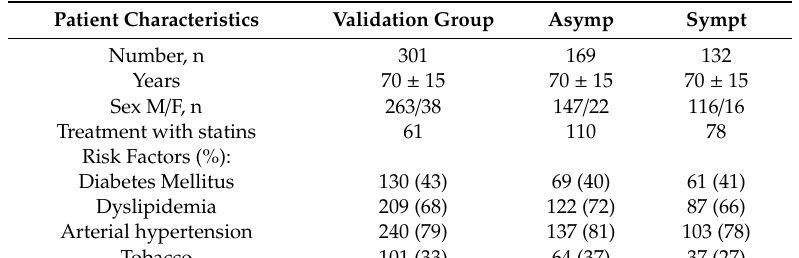
Table A2. Clinical and demographic patient data from the Biocruces Bizkaia cohort samples. Samples used for SNP validation analysis by genotyping.